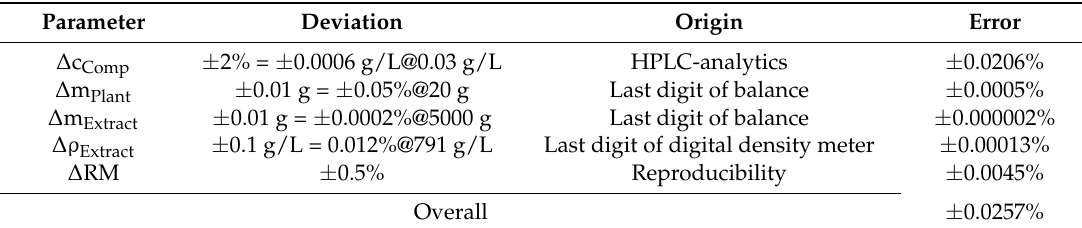
Table 2. Error propagation for the overall amount